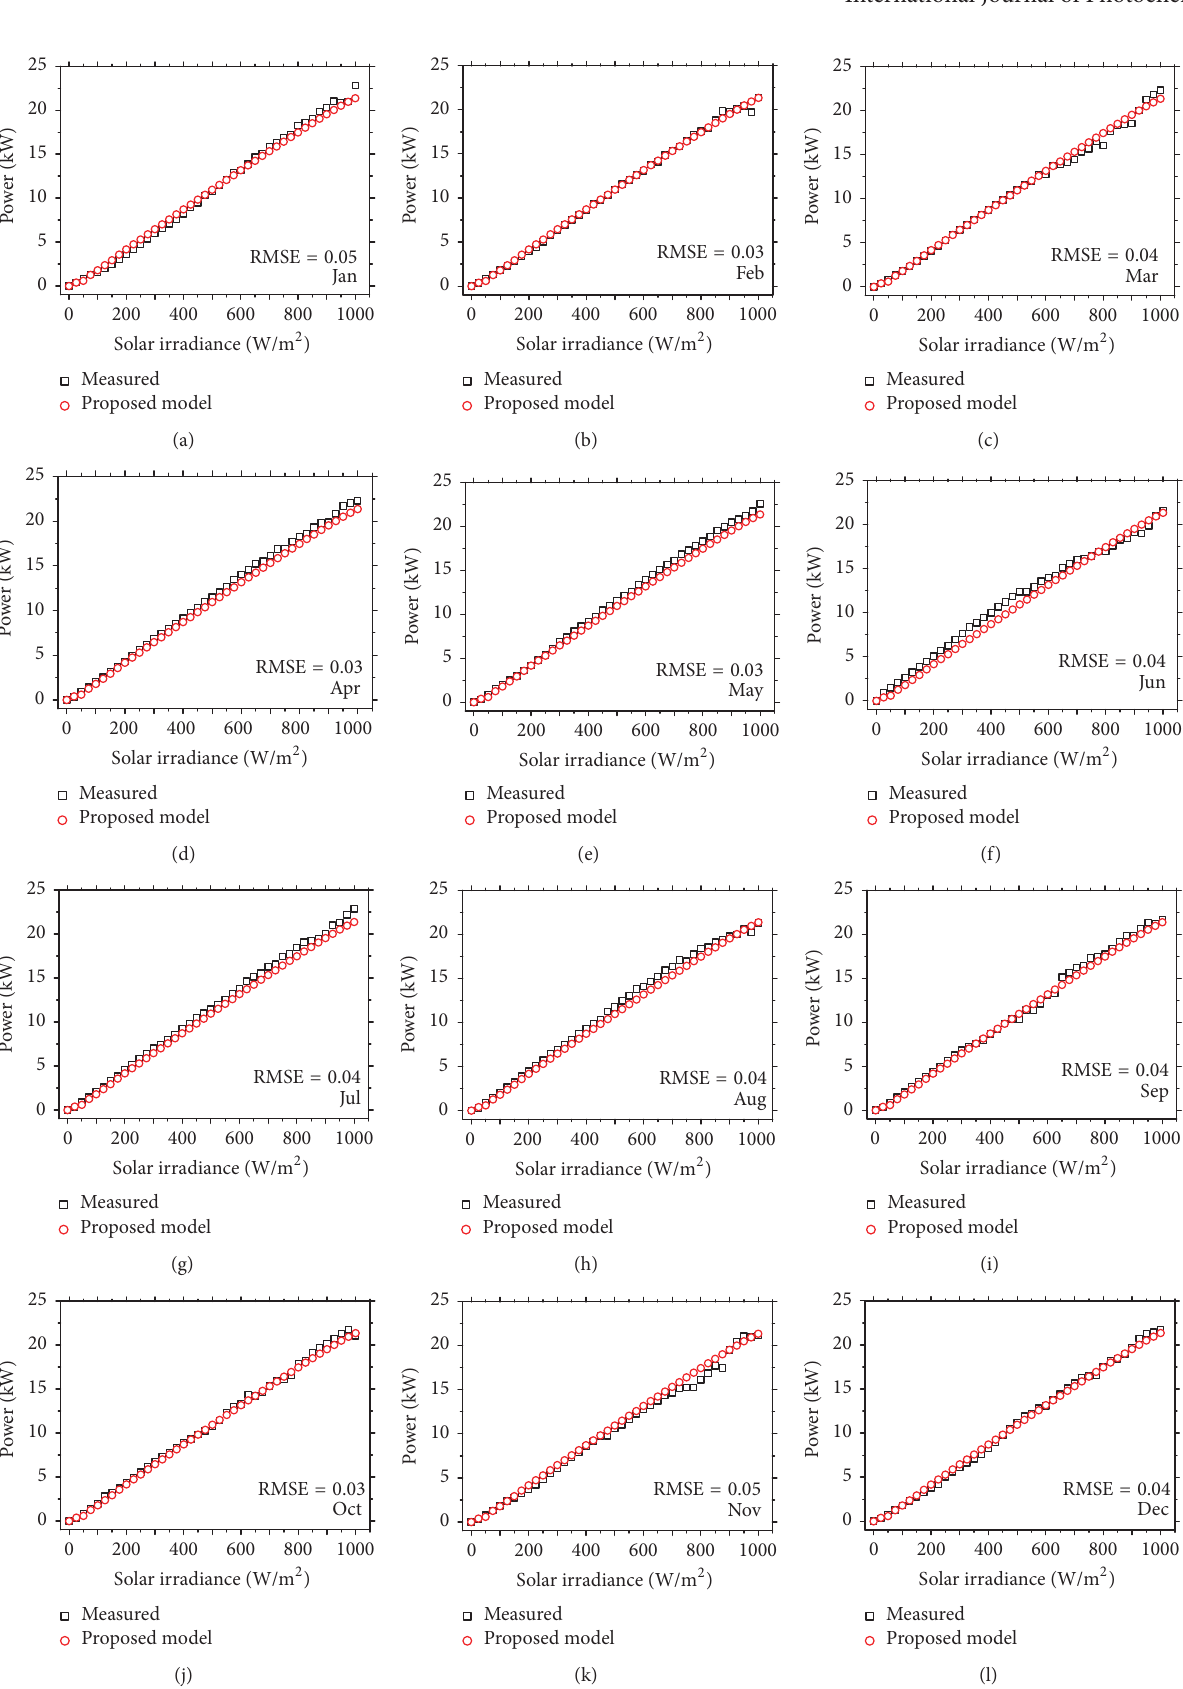
Figure 9: Comparisons of the measured data and simulated PV power